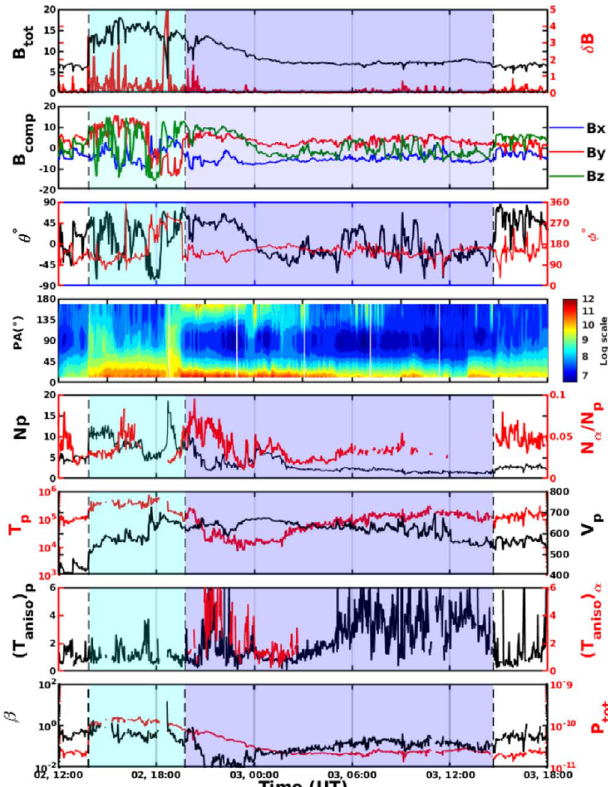
Figure 1. Plot of the WIND data over the interval 2005 September 2 12:00:00 to 2005 September 3 18:00:00 UT. From top to bottom: interplanetary magnetic fi eld ( IMF ) strength B tot overlaid with δ B , a component of the magnetic fi eld B comp , the IMF orientation of θ and f , the pitch angle ( PA ) of suprathermal electron strahls, the variation of number density N p and N N p / a . the variation of temperature ( T p ) and velocity ( V p ) of protons, the anisotropy in proton temperature T p aniso ( ) and α - particle temperature T aniso ( ) a , and the plasma β overlaid with plasma thermal pressure P tot